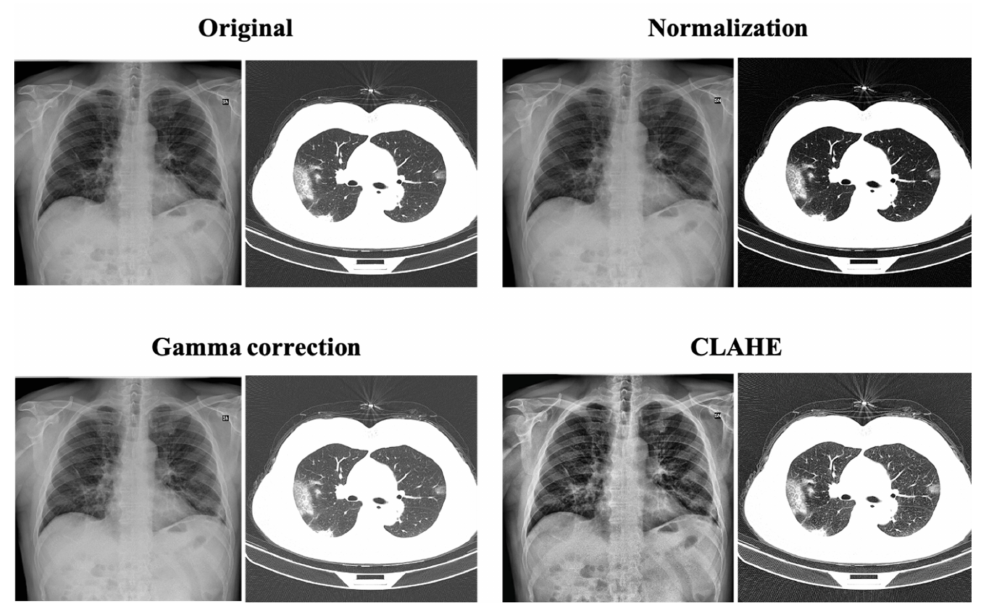
Figure 3. Original image vs. the images after various enhancement